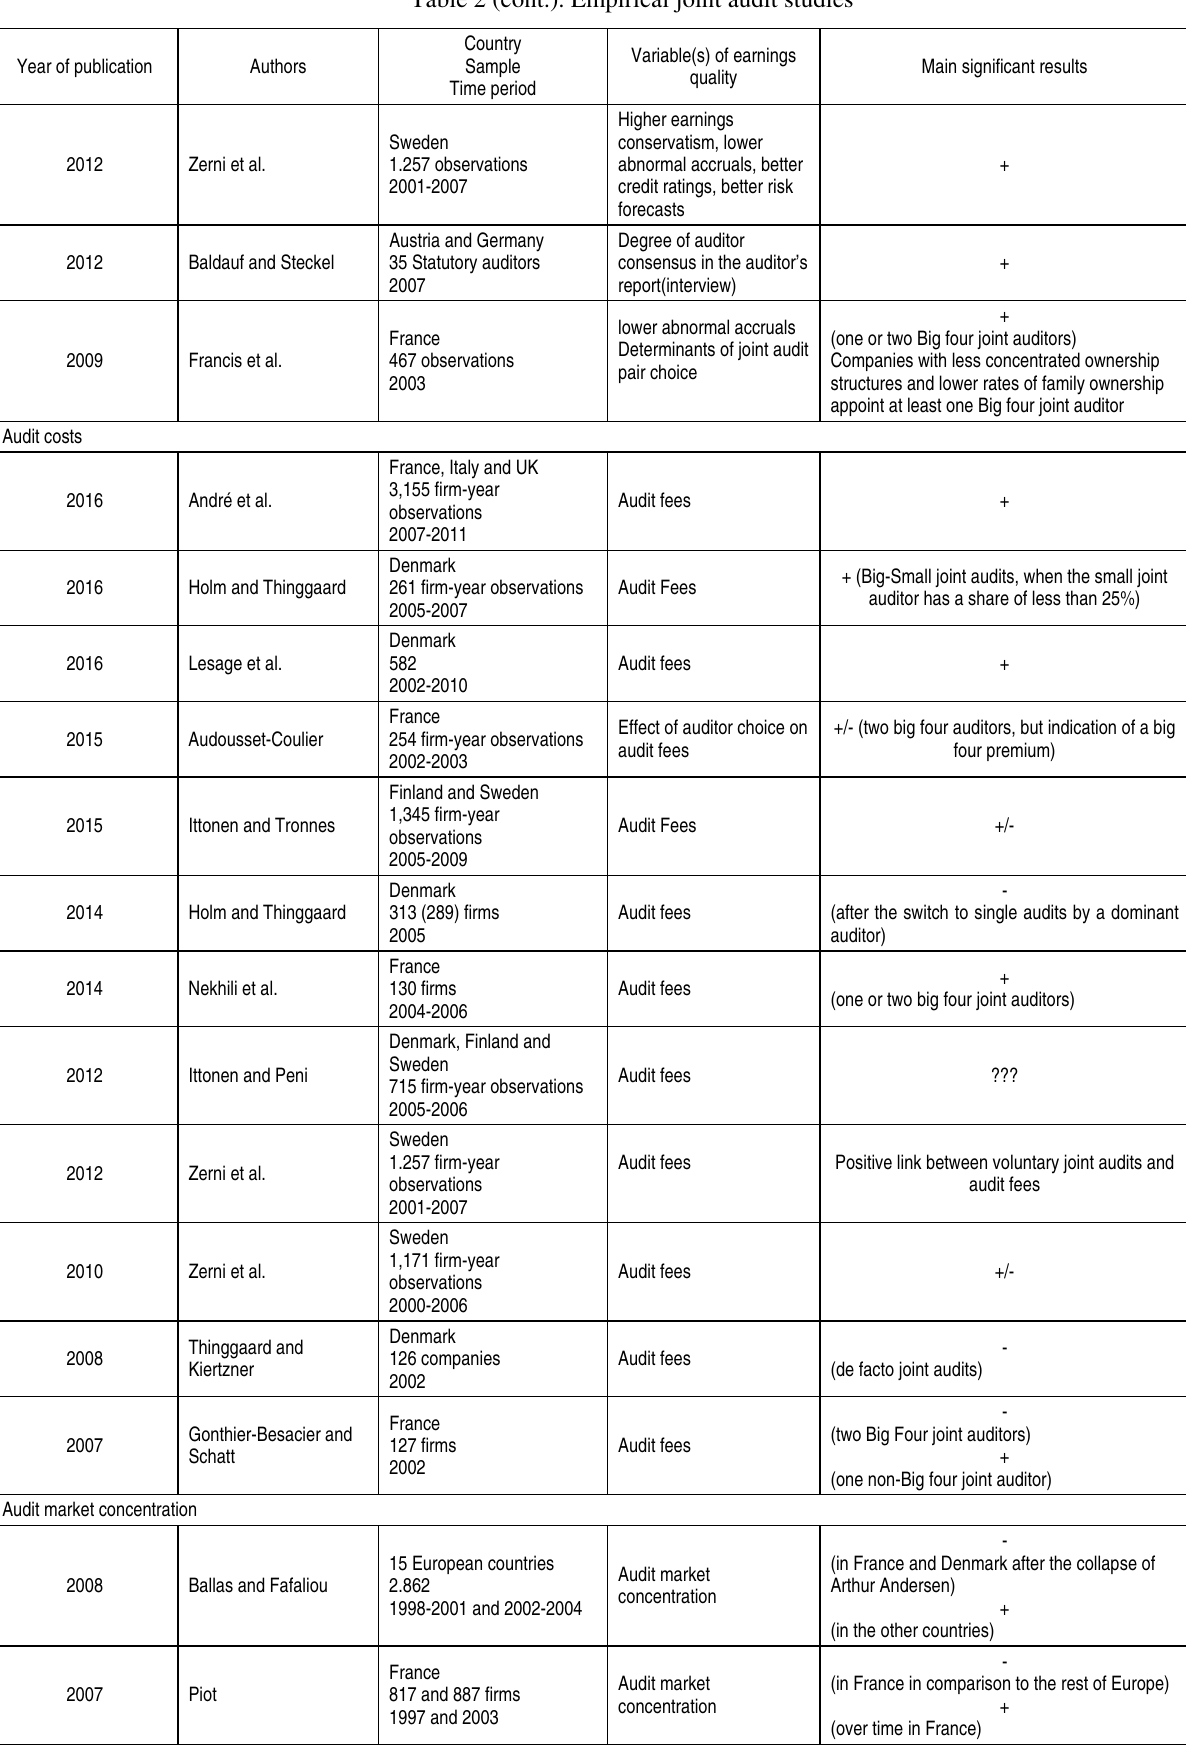
Table 2 (cont.). Empirical joint audit